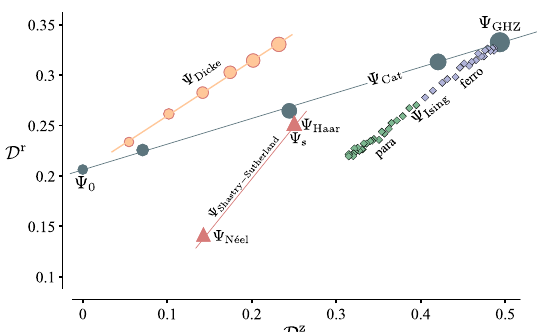
Fig. 10 Dissimilarity map. Low-dimensional representation of the 16-qubit quantum states studied in this work with respect to their dissimilarity calculated in σ z and random bases. Ψ 0 , Ψ s , Ψ Haar denote the trivial 0 j i (cid:2) N , the singlet and the random quantum states,